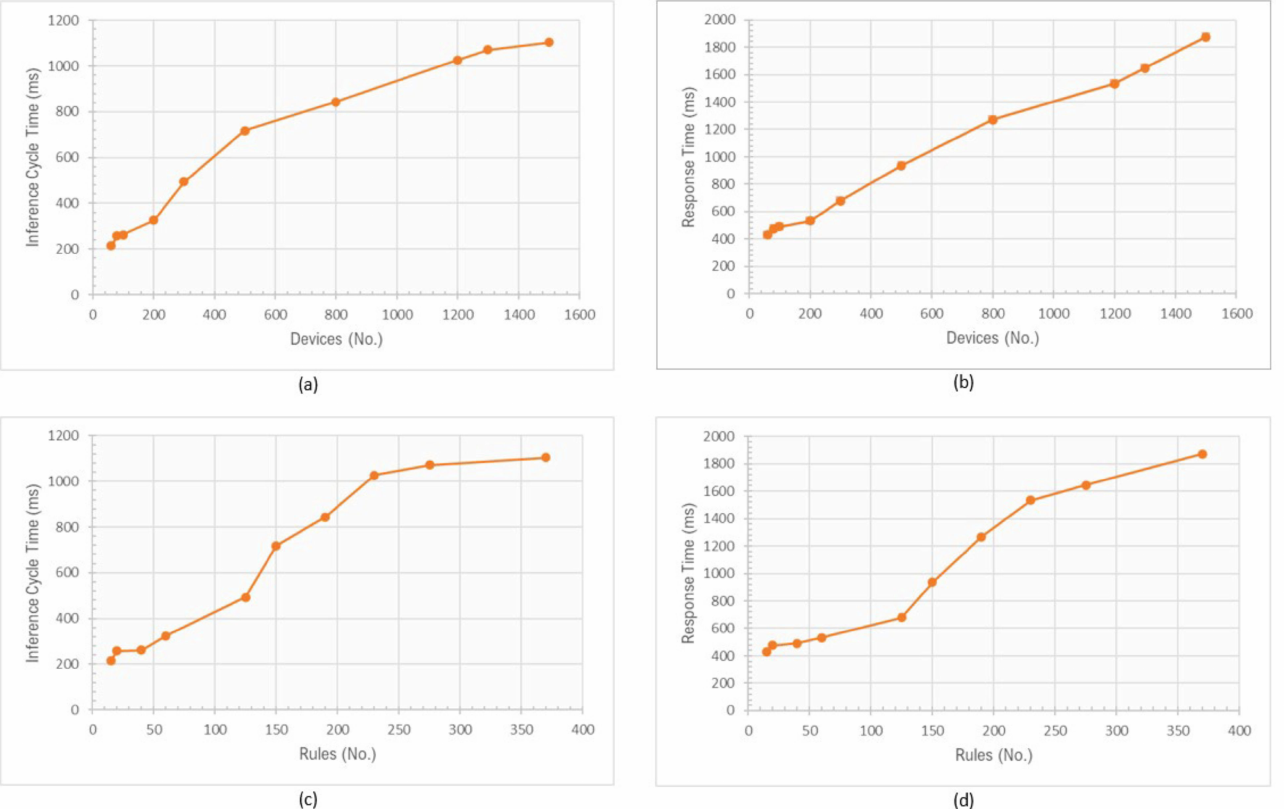
Figure 15. Correlation between ( a ) number of devices and inference cycle time, ( b ) number of devices and response time, ( c ) number of rules and inference cycle time, ( d ) number of rules and response